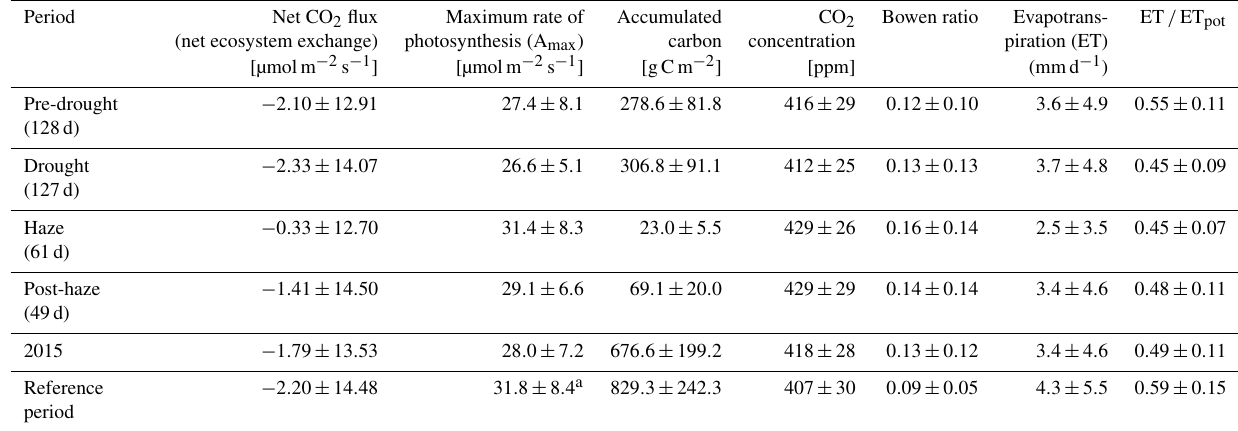
Table 2. Net CO 2 flux, maximum rate of photosynthesis (A max ), accumulated carbon, atmospheric CO 2 concentration, Bowen ratio, evapo- transpiration (ET) and actual ET divided by potential ET (ET / ET pot ) (daily mean ± SD, or accumulated for precipitation and carbon) derived from 30min averages or the daily average ( A max , Bowen ratio) during the pre-drought, non-haze drought, haze drought and post-haze periods